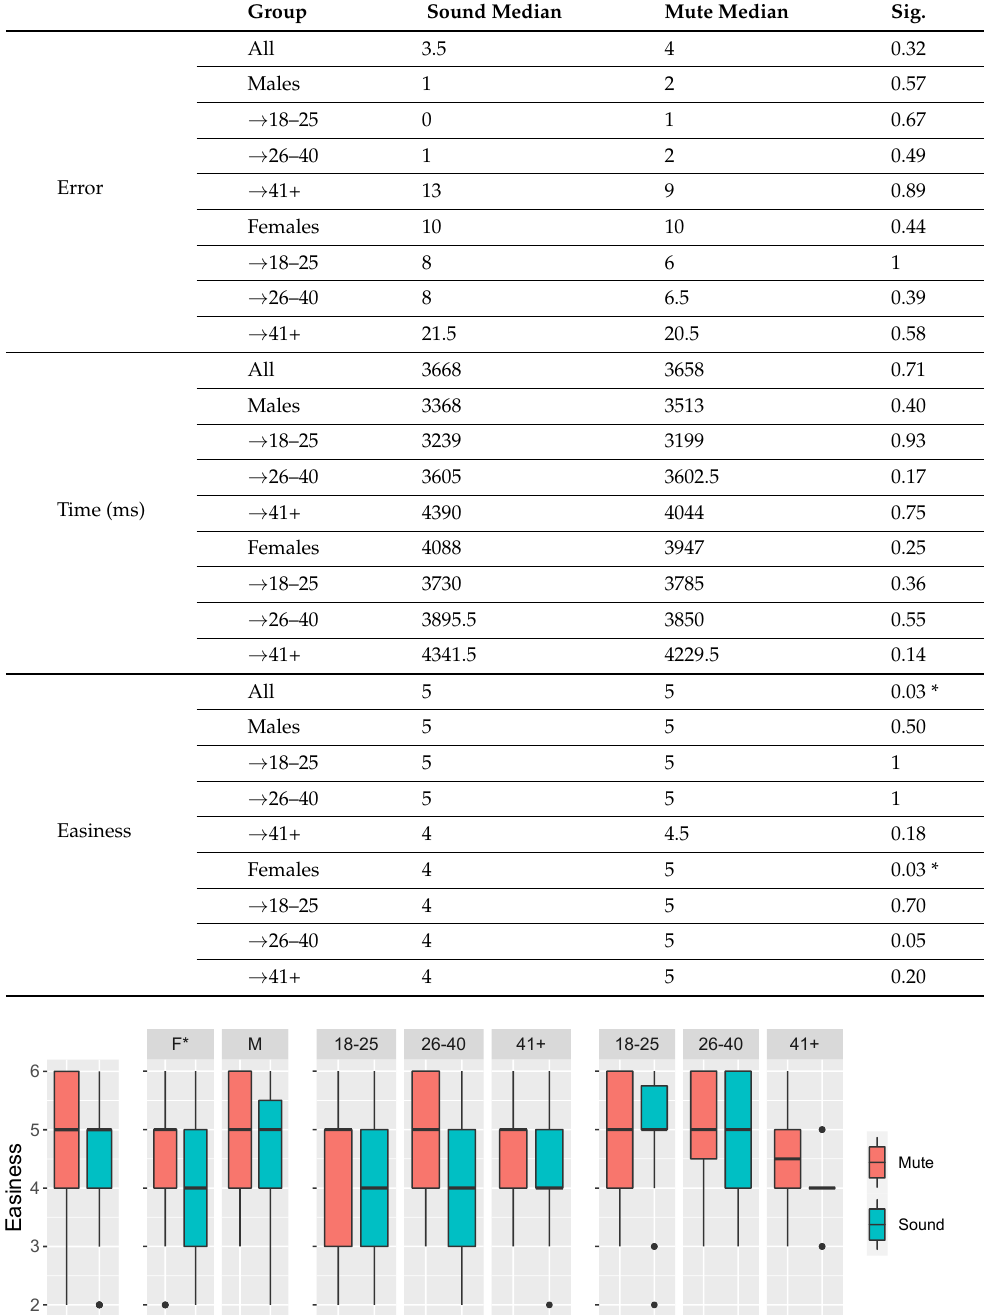
Table 2 shows comparisons across all age groups and genders with p -values for error rate, time of activation and ease of synchronization. Table 2. Condition comparison regarding Error, Time, and Easiness of synchronization for all age group. Significant differences are marked with asterisk.